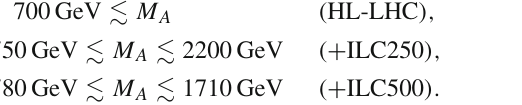
assumed point at ( M A , tan β) = ( 700 GeV , 3 ) amount